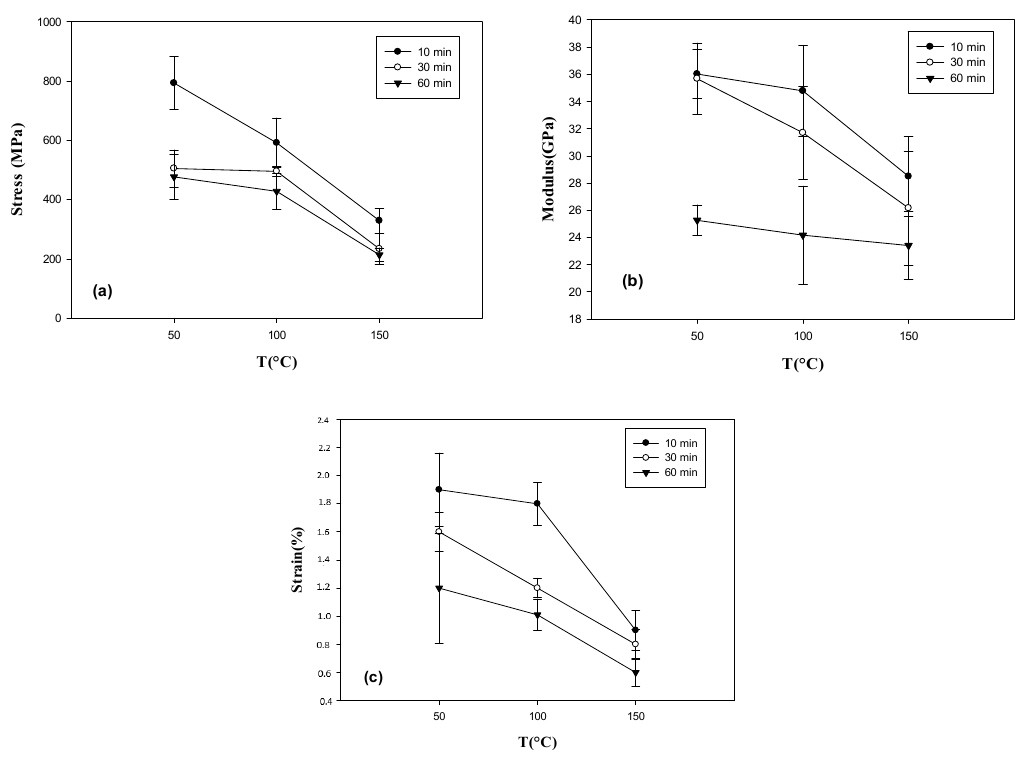
Figure 4. Tensile properties per temperature and temperature hold time. ( a ) Stress data scatter, ( b ) Young’s modulus data scatter, and ( c ) Strain data scatter. Table 3. Estimated Weibull parameters per gage length and cross-head